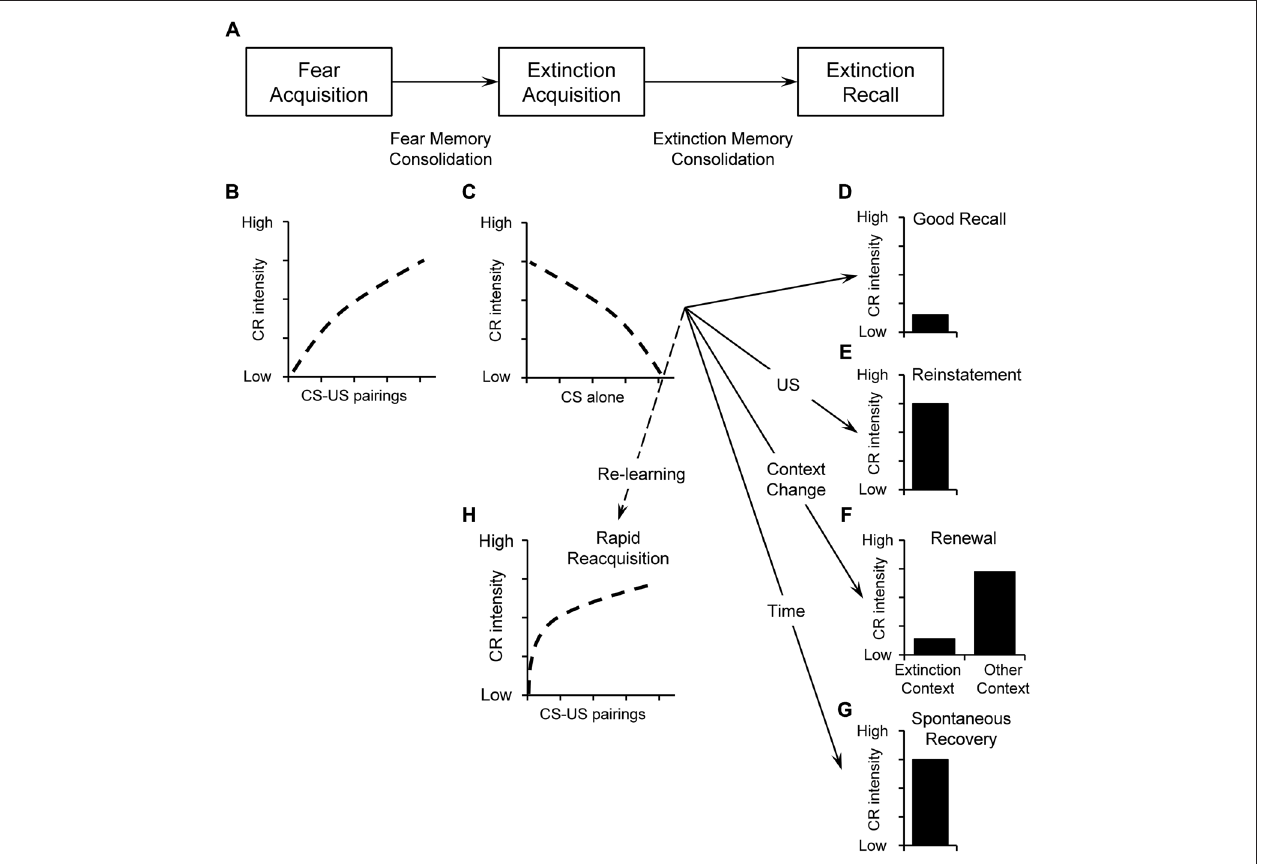
FIGURE 1 | (A) Illustration of basic stages of fear and extinction learning and memory including acquisition, consolidation, and retrieval. During initial pairings between the conditioned stimulus (CS) and the unconditioned stimulus (US) during fear acquisition , responses increase over time (B) . Fear memory is consolidated thereafter. During extinction acquisition , the CS is repeatedly presented without the US and the conditioned responses (CR) decline with increasing number of CS alone presentations (C) . After consolidation, extinction recall can be tested by presenting the CS again. Good extinction recall is evident when CS-presentation triggers retrieval of the extinction memory trace and only low levels of CR occur (D) . Poor extinction recall—or return of fear—is evident in high conditioned responses despite successful extinction. Poor extinction recall can be caused by reinstatement , i.e., presenting the aversive US (E) , renewal , i.e., presenting the CS in a new context different from the extinction context (F) , or spontaneous recovery : i.e., by the passage of time (G) . Despite successful extinction acquisition, new CS-US pairing will result in faster reacquisition of the CR i.e., rapid reacquisition (H)